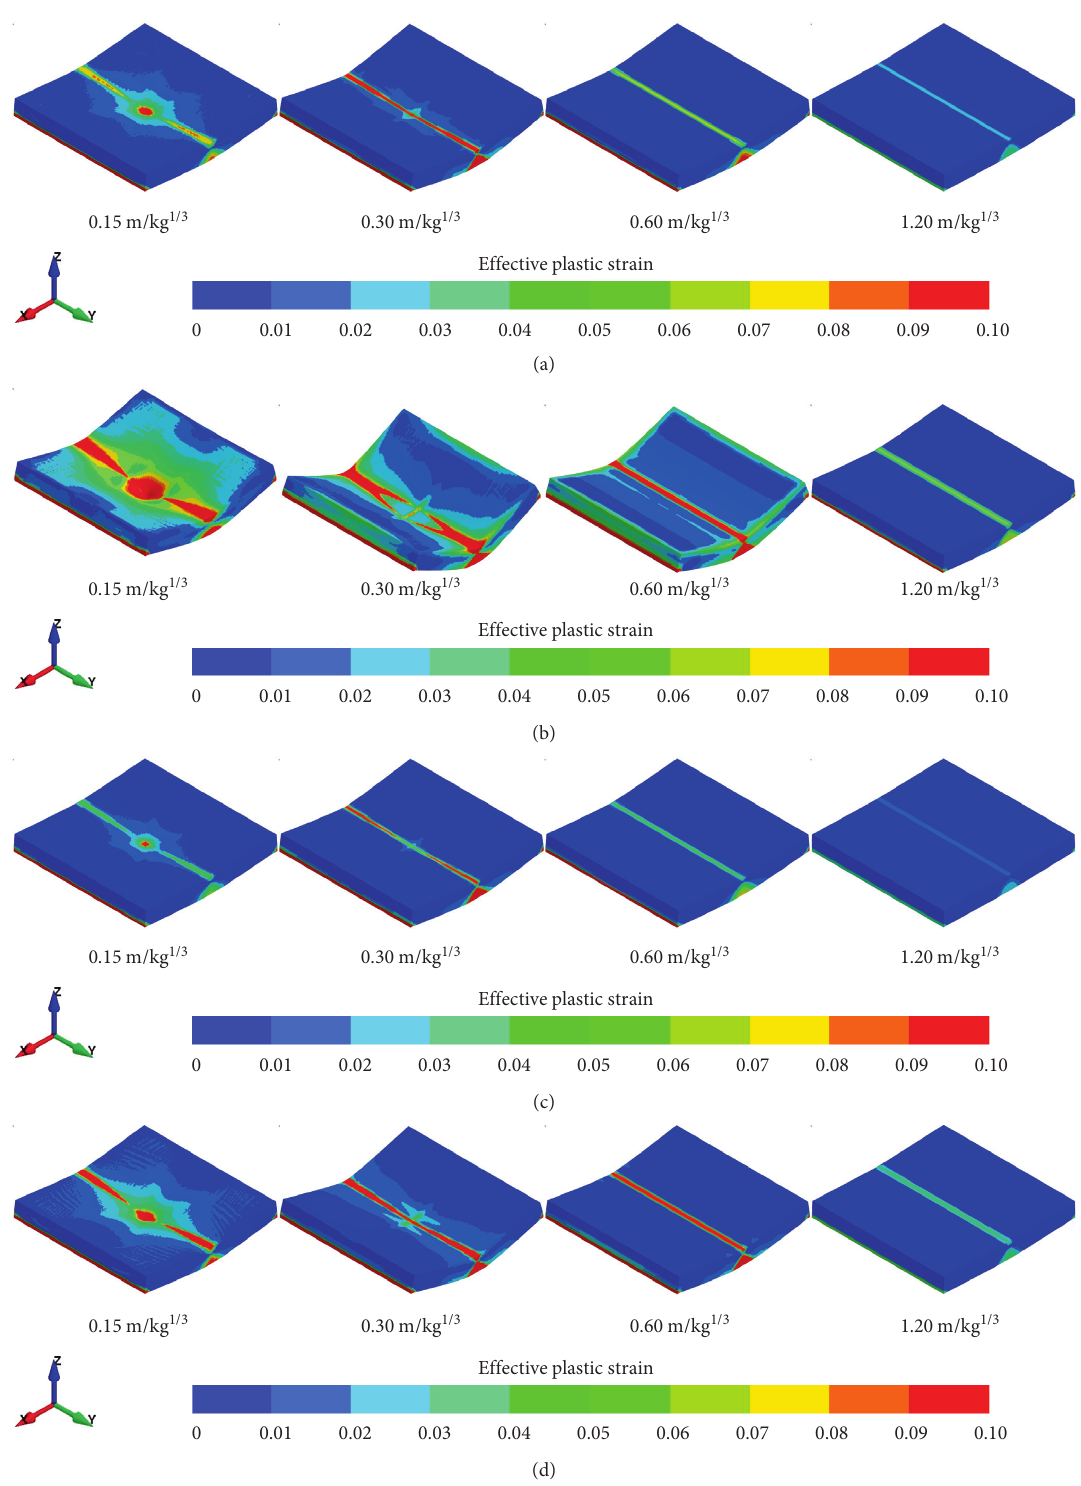
Figure 4: Plastic strain distribution in (a) chuanshan limestone, (b) gaolishan sandstone, (c) mineralized limestone, and (d) xixia limestone panels under blast loadings with various scaled